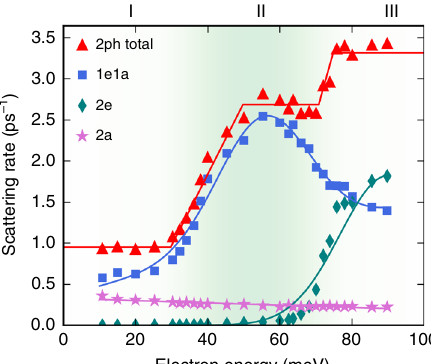
Fig. 5 Process-resolved two-phonon scattering rate. Contributions to the 2ph scattering rate in GaAs at 300 K. The scattering rates of the 1e1a, 2e and 2a processes are shown, together with their sum, the total 2ph scattering rate. The solid curves are fi ts of the data drawn to guide the eye.